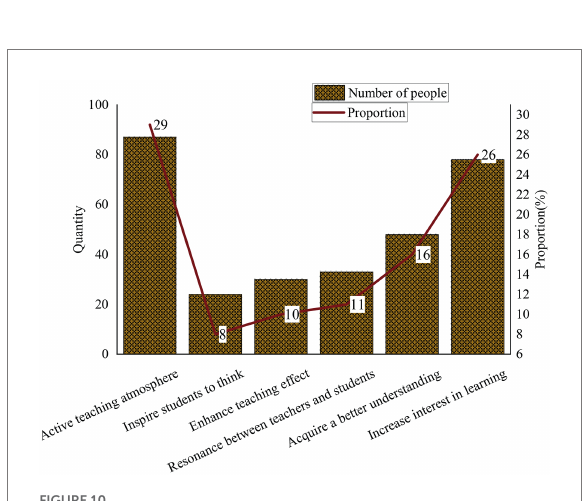
FIGURE 8 The mastery of the basic connotation of English vocabulary by college students.